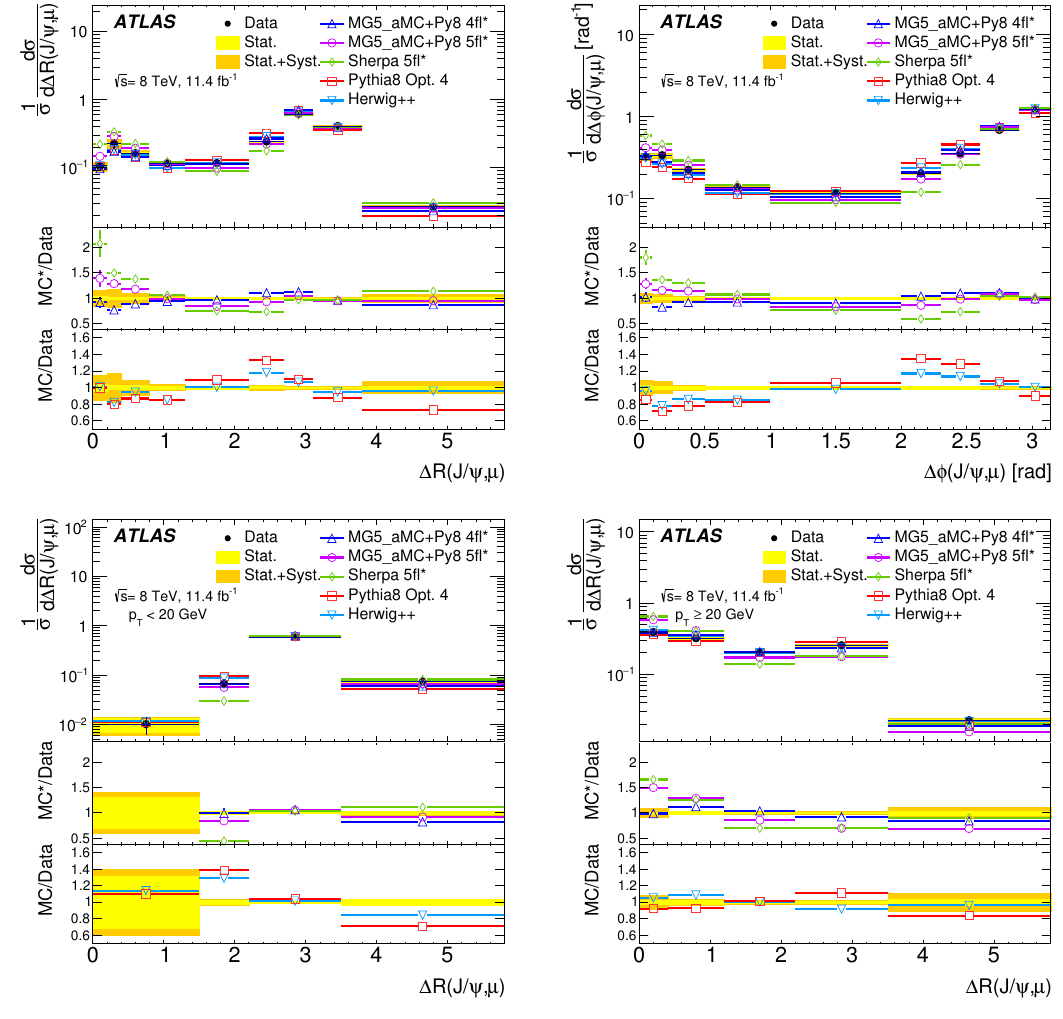
Figure 7 . Measured normalised di(cid:11)erential cross sections as a function of (cid:1) R ( J= ; (cid:22) ), (cid:1) (cid:30) ( J= ; (cid:22) ), low- and high- p T (cid:1) R ( J= ; (cid:22) ). Comparisons are made with predictions of Pythia8 and Her- wig++ . MadGraph5 aMC@NLO + Pythia8 and Sherpa predictions are also compared having been corrected from the two- b -hadron production to the three-muon (cid:12)nal state via transfer functions (indicated with *). There is no entry for these predictions in the lowest low- p T (cid:1) R ( J= ; (cid:22) ) bin as the transfer function is not de(cid:12)ned in this bin. The Pythia8 \Opt. 4" gluon-splitting parameter settings are described in table 1. The ratio to data of the MadGraph5 aMC@NLO + Pythia8 and Sherpa (middle pane), and Pythia8 and Herwig++ (bottom pane) are also